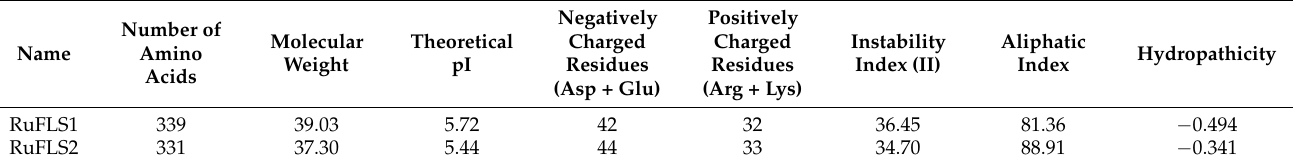
Table 1. Physicochemical properties of RuFLSs.